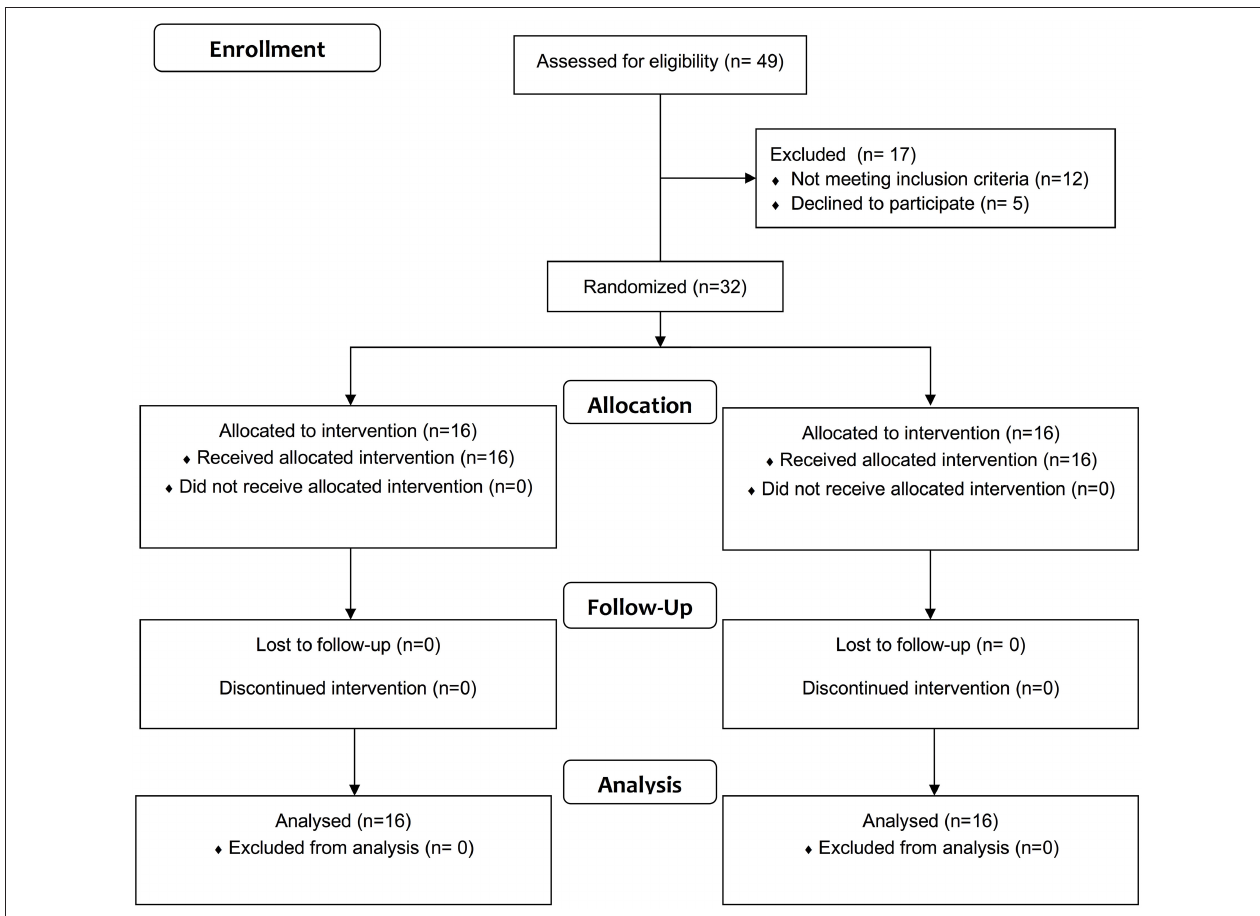
FIGURE 2 | Flow diagram of the